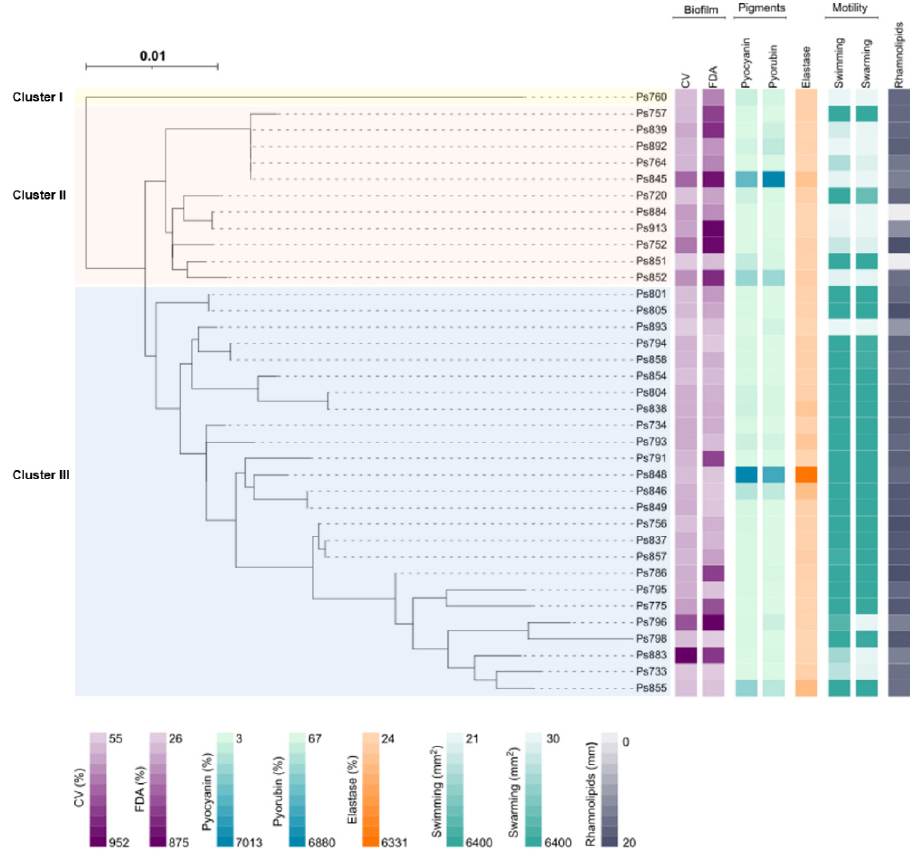
Figure 1. Maximum-likelihood phylogenetic tree based on the sequence type (MLST) and phenotypic characteristics of the 37 P. aeruginosa strains analysed in this study. The phylogenetic tree was obtained using the IQTREE v.1.6.1 [14] software. The iTol v.4 [15] program was used to visualise the phylogenetic tree and to perform the eight heatmaps. In order: biofilm biomass production (CV), bacterial metabolic activity inside the biofilm (FDA), pyocyanin and pyorubin production, elastase activity, swimming and swarming motility and rhamnolipids production. Legend values belong to the minimum and maximum data for each phenotypic assay (Table 2). The three clusters (I, II and III) were marked with different colours: yellow (Cluster I), red (Cluster II) and blue (Cluster III).